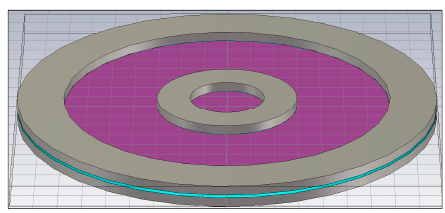
Figure 14. Design of the coaxial waveguide in CST.